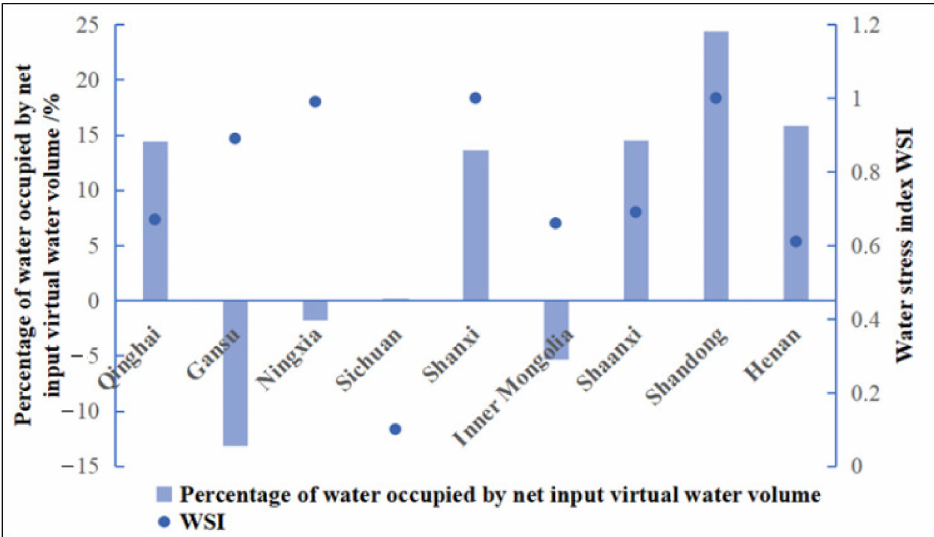
Figure 10. Virtual water external dependence and water stress